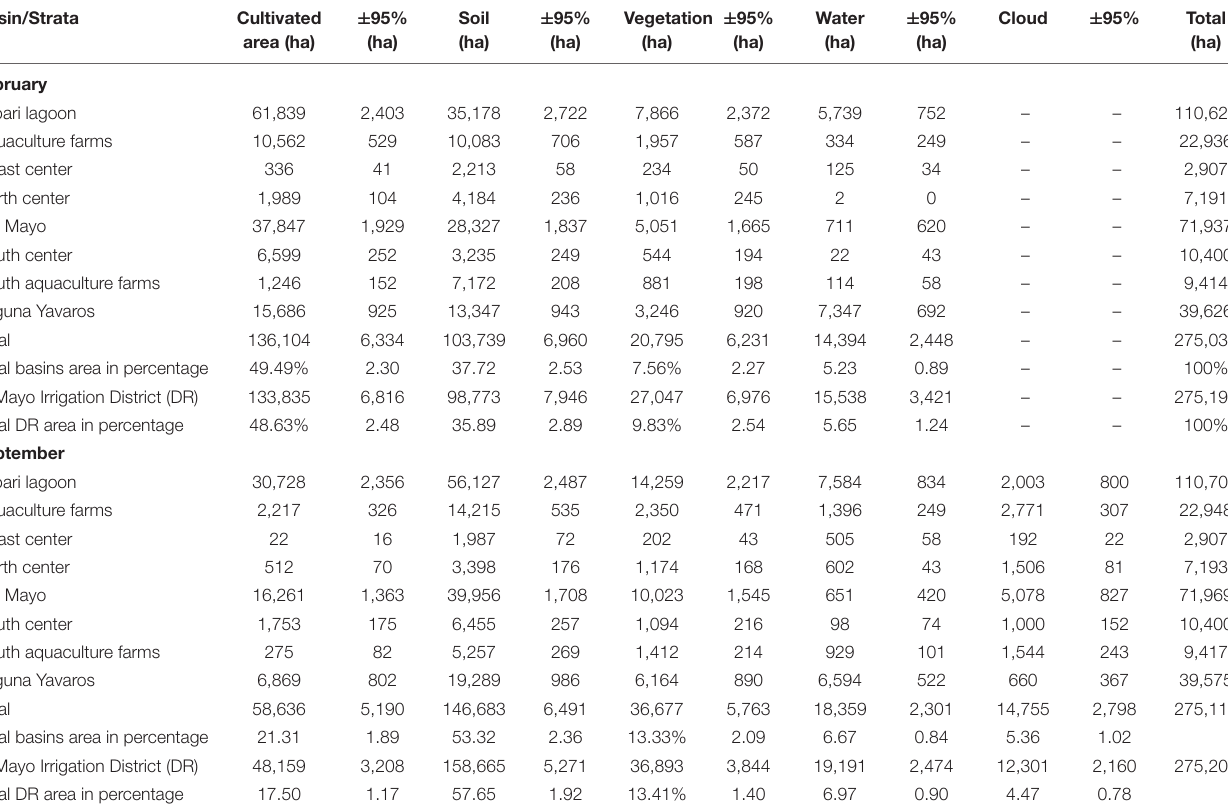
TABLE 2 | Area that covers each class, as well as its estimation